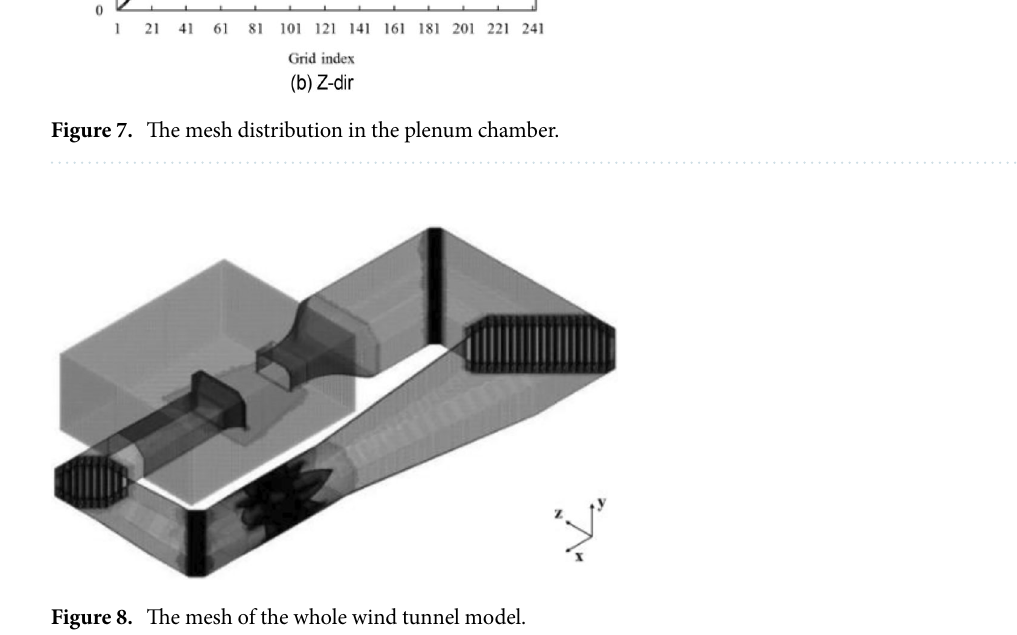
Figure 8. The mesh of the whole wind tunnel